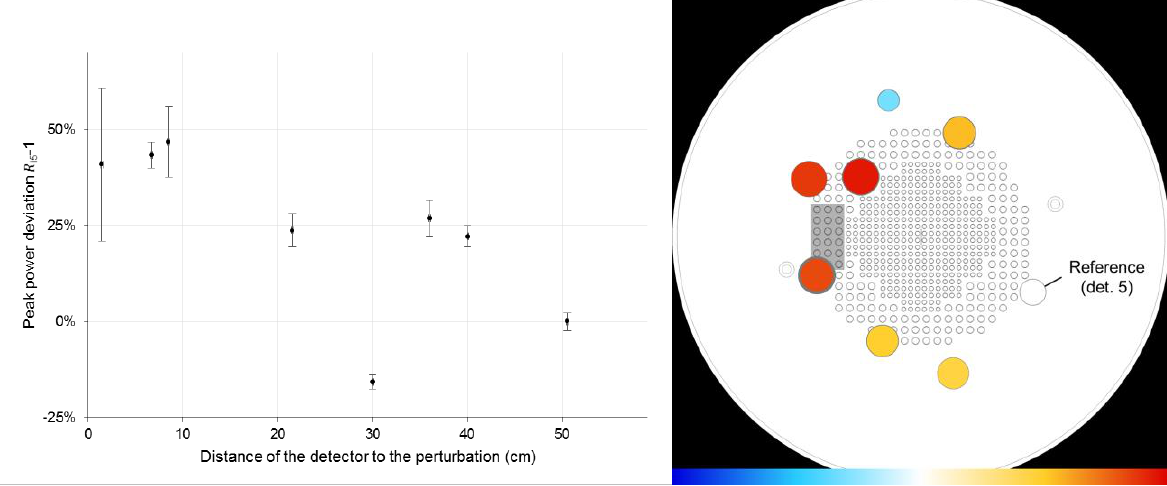
Figure 6. Relative difference in noise levels with respect to detector 5, as a function of distance to the boundary of the perturbation (left), and on the CROCUS map (right). The COLIBRI perturbation area is represented by the grey rectangle. The differences are linearly coded in color from blue (min. -50%) to red (max. +50%), with respect to the reference in white (0%), as well as in disk area (50% additional area corresponds to +50% in noise). The thickness of the disks’ rim corresponds to the